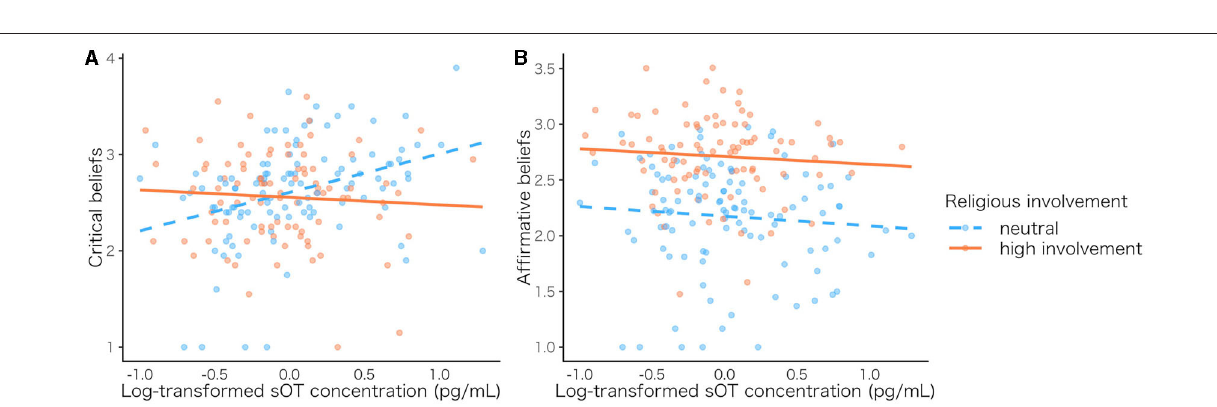
FIGURE 3 | Scatterplots between sOT levels and the two aggregated subscales. Relationship between sOT level and critical beliefs (A) and sOT level and affirmative beliefs (B) . sOT, salivary oxytocin. Each point represents the average score of each participant.